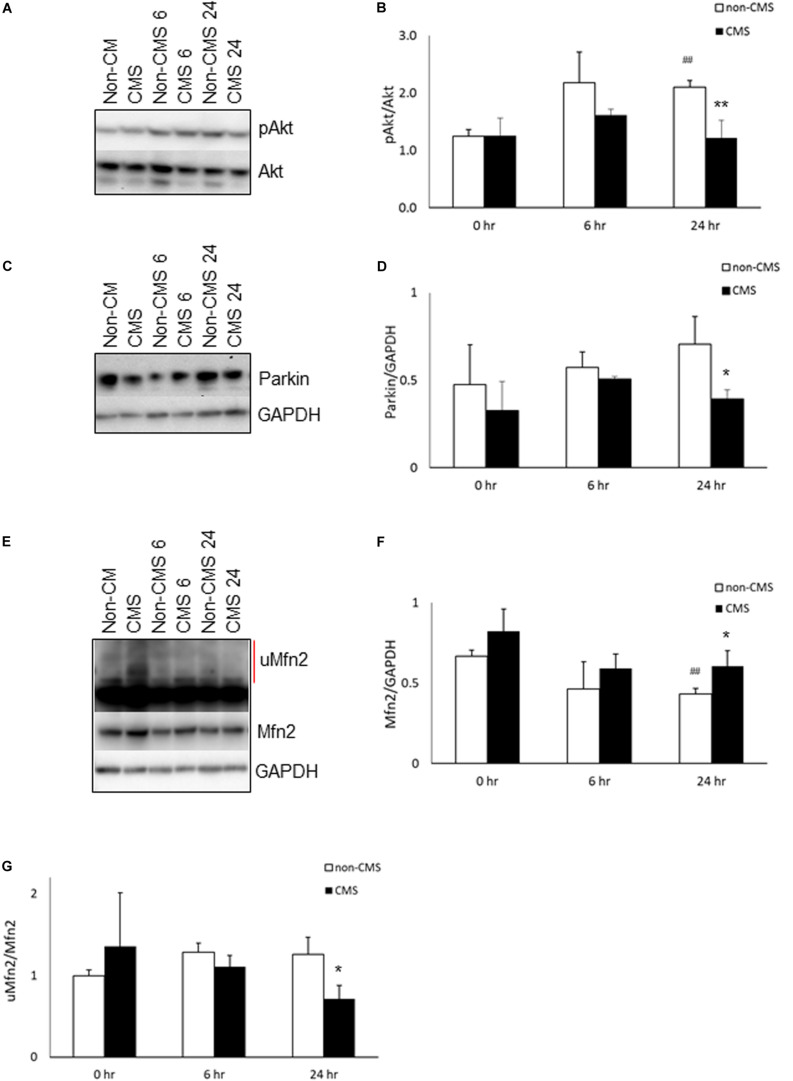
Akt activation in CMS. (A) A representative blot of pAkt and Akt in iPSC-derived non-CMS neurons (n = 3) and CMS neurons (n = 3) following hypoxia (1% O2) treatment for 0, 6, and 24 h. (B) Densitometry analysis of Akt. (C) A representative blot of Parkin in iPSC-derived non-CMS neurons (n = 3) and CMS neurons (n = 3) following hypoxia (1% O2) treatment for 0, 6, and 24 h. (D) Densitometry analysis of Parkin. (E) A representative blot of Mfn2 in iPSC-derived non-CMS neurons (n = 3) and CMS neurons (n = 3) following hypoxia (1% O2) treatment for 0, 6, and 24 h. Red line indicates the ubiquitylated Mfn2 (uMfn2). (F) Densitometry analysis of steady state of Mfn2 and (G) densitometry analysis of uMfn2. * indicates p < 0.05 and ** indicates p < 0.01 as compared to non-CMS neurons at a given time point. ## indicates p < 0.01 as compared to themselves under normoxia.